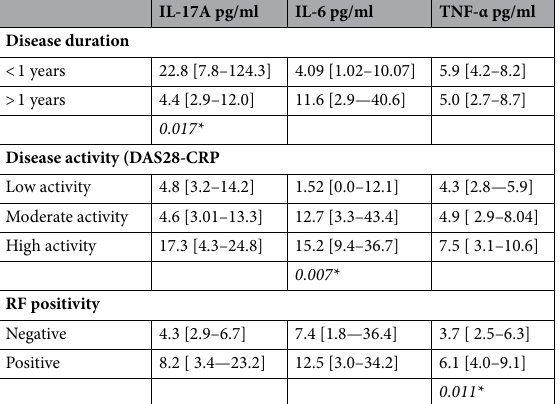
Table 3. Significant differences in cytokine levels in relation to RA disease characteristics in female patients. Data are presented as median (IQR). *p-value according to Mann–Whitney U